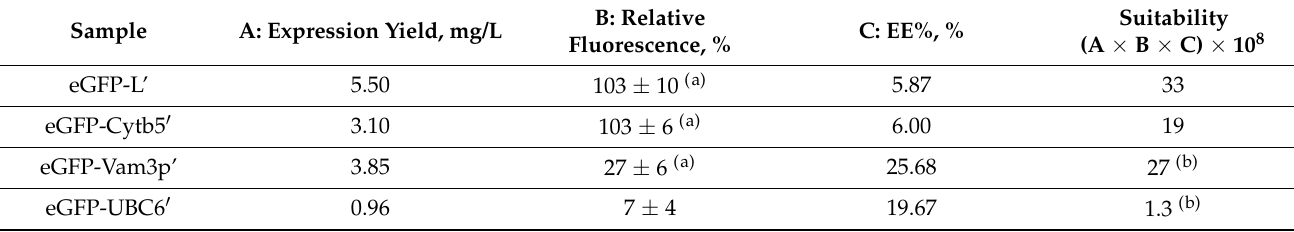
Table 2. Overview of the expression yield of the membrane-anchored eGFP variants per liter bacterial culture, their relative fluorescence compared to eGFP without membrane anchor, and their encapsulation efficiency at the loading optimum resulting in the highest number of encapsulated proteins. The suitability of the constructs is calculated as product (A × B × C). To get a dimensionless number, the expression yield was transformed into a weight/volume percentage concentration for this